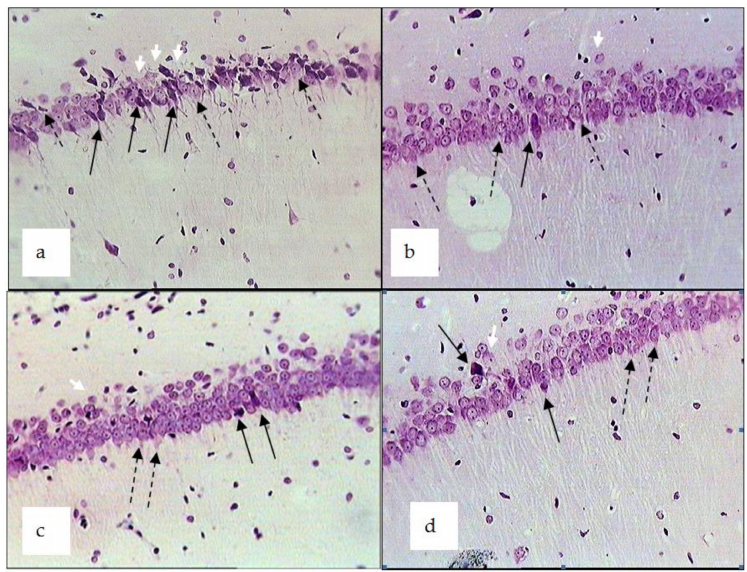
Figure 7. Dorsal hippocampus CA1 (ipsilateral side) in rats subjected to chronic emotional stress (CES) and ischemia ( I ). Experimental groups: CES + I ( a ); CES + I + R. uniflorum ( b ); CES + I + S. centauroides ( c ); CES + I + R. carthamoides ( d ). Solid black arrow—hyperchromic shrunken neurons; white arrow—cytolysis; dotted arrow—dystrophic changes to neurons; disintegration of the pyramidal layer. Stained with cresyl violet. Magnification ×